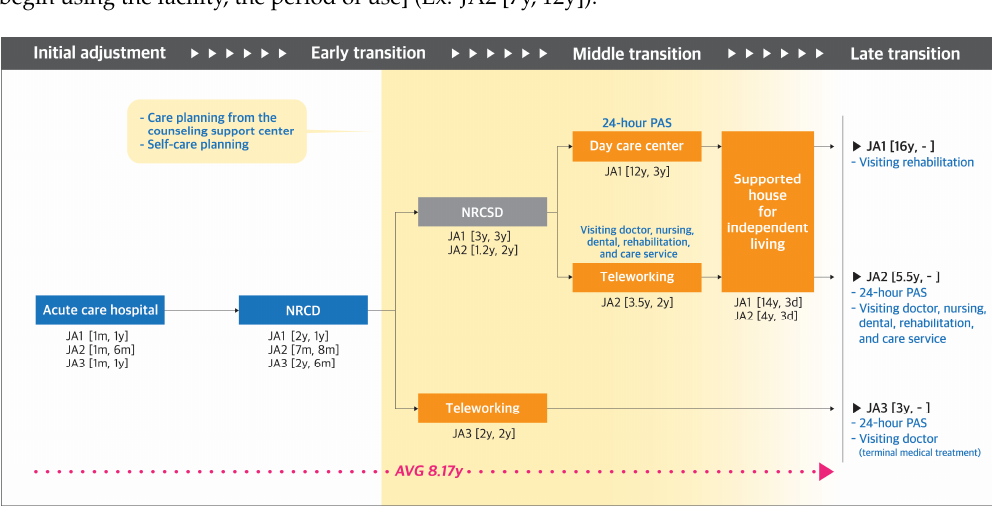
grey color in the square respectively indicate facilities providing medical, welfare, participant code [the time taken to begin using the facility, the period of use] (Ex. JA2 [7y, 12y]).